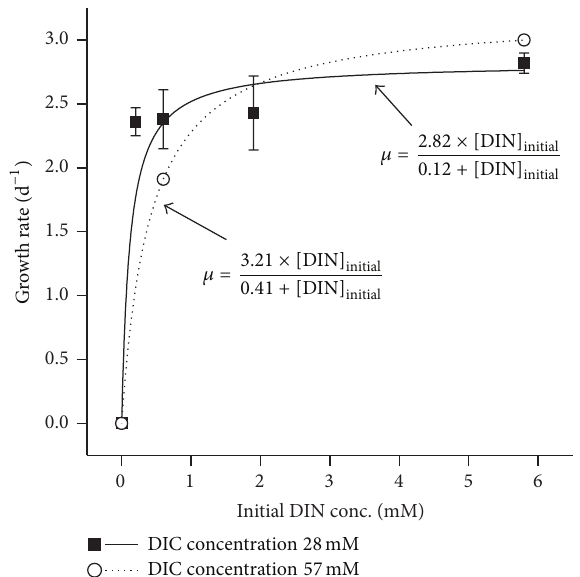
Figure 4: Monod-type equations under various DIC and DIN concentrations in a batch culture.